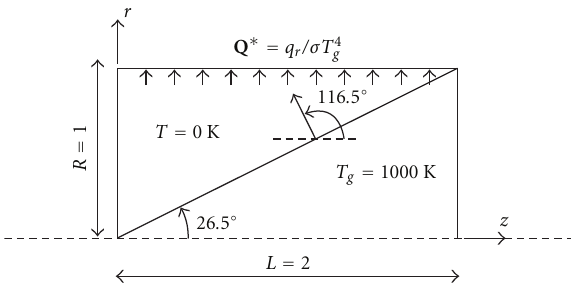
Figure 3: Geometry for test case II.